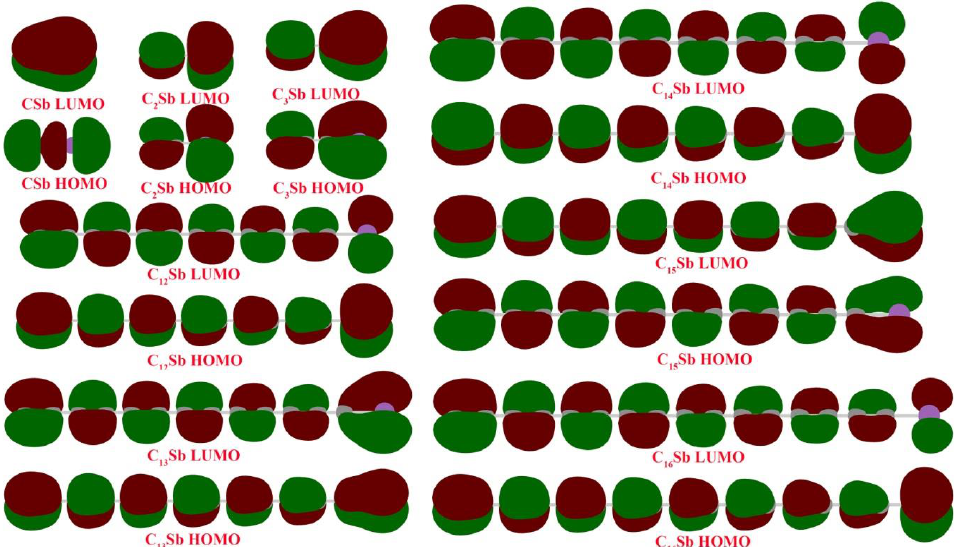
Figure 7. Highest occupied molecular orbitals (HOMO) and lowest unoccupied molecular orbitals (LUMO) for carbon chain clusters. The surface isovalue for molecular orbitals is 0.02.